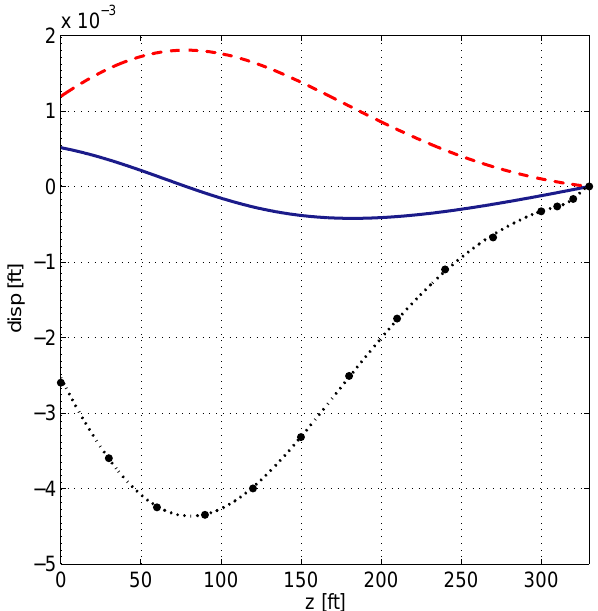
Figure 13. Hyperboloid of revolution under wind load. Displacement components: u —blue solid line, v —red dotted line, w black dashed-dotted line - present results vs. black bullets— reference results